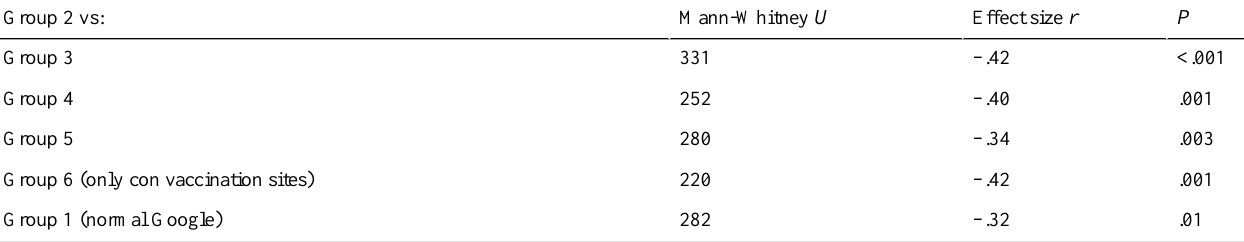
Table 2. Differences in user fears of vaccination between group 2 (only high-quality pro sites) and all